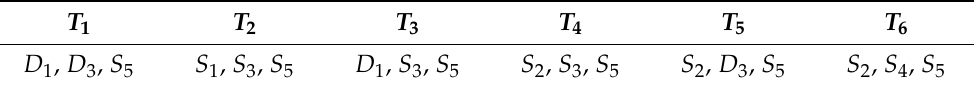
Table 4. Conduction of switches in different time intervals in FC2BDC- Boost